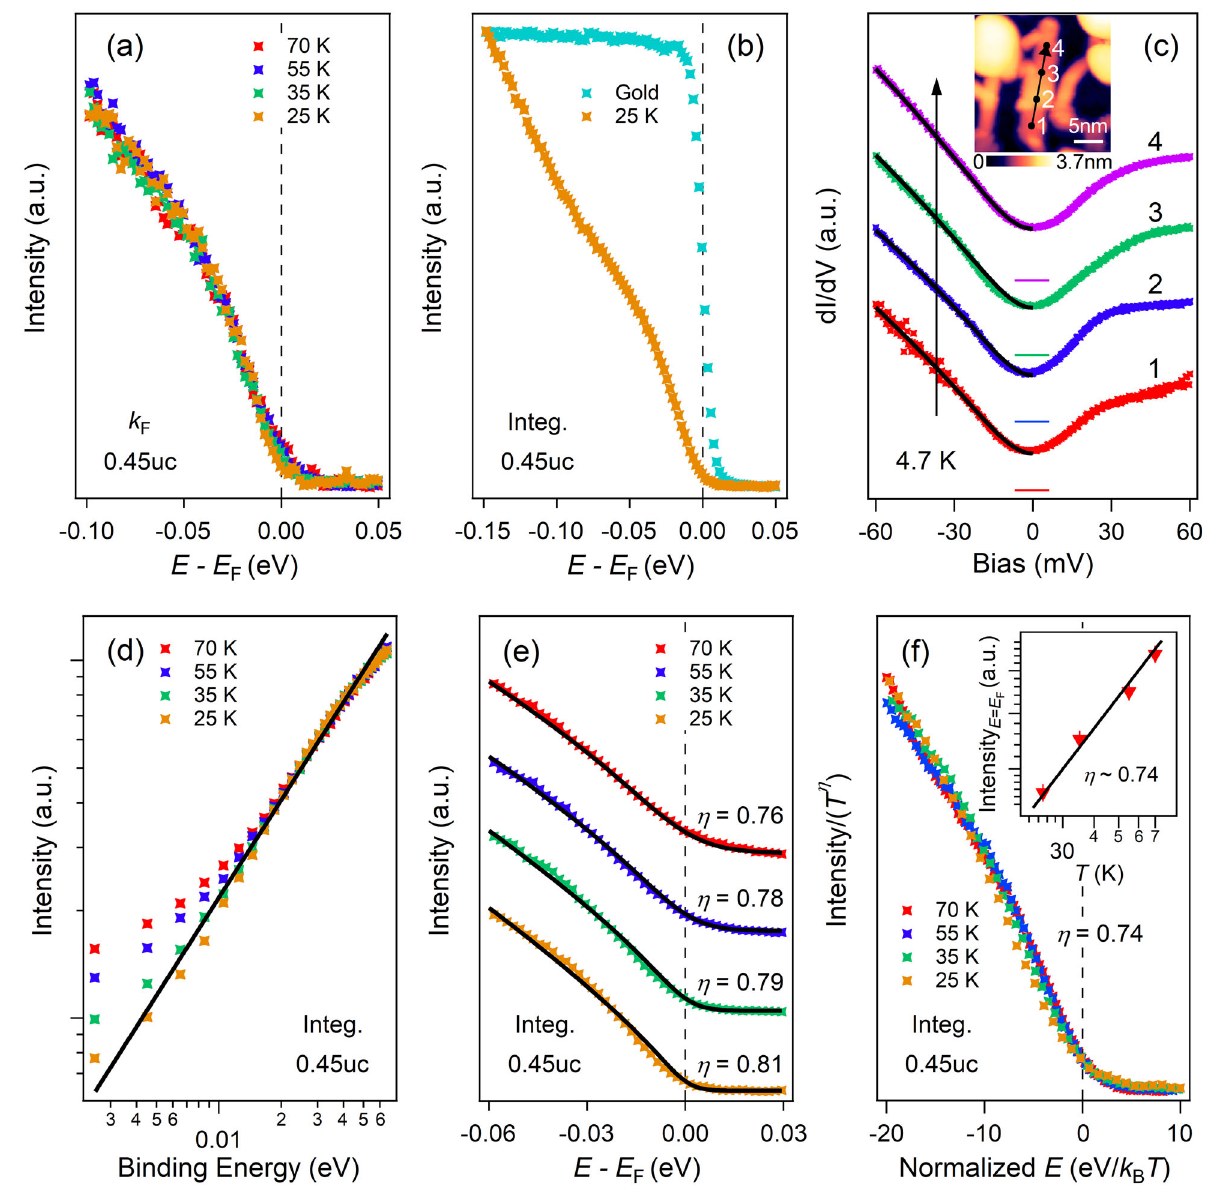
Fig. 3 Evidence of TLL state in CoSb 1 − x nanoribbons. a Temperature-dependent EDCs taken at k F (cut#1 in Fig. 2b) of Sample I (0.45 uc). b Integrated spectra (cut#1 in Fig. 2b) at T = 25 K in the range of − 0.56 < k y < 0.56 Å − 1 , compared to a polycrystalline Au spectrum. c d I /d V spectra taken along the black arrow in the inset on an individual nanoribbon, with V s = 60 mV, I = 100 pA ( T = 4.7 K, Δ E ~ 2 mV). For clarity, each spectrum is offset with a constant conductance and the zero is indicated by a horizontal bar. The black curves are the fi ttings to the TLL model. The asymmetric amplitude of DOS may originate from the local electronic states affected by the size effect of nanoribbons. Inset: STM topography of CoSb 1 − x measured with V s = 0.8 V, I = 30 pA. d Logarithmic plot of the temperature-dependent integrated spectra [same as ( b )]. The black line is a linear fi t of data at 25 K in the binding energy range of 3 – 60 meV. e Same as ( d ) plotted in a linear scale. The spectra are vertically shifted for clarity. The black curves are the fi ttings to Eq. (1), convolved with Gaussian function of instrumental energy resolution ( Δ E ~ 9 meV). f Universal scaling plot of the spectra in ( e ), where the spectral intensity is scaled as I / T 0.74 , and energy is normalized to E / k B T . Inset: logarithmic plot of the temperature-dependent spectral intensity at E F , where the data are extracted from ( e ). The black line is a linear fi t, implying the power-law-like behavior with a power index of